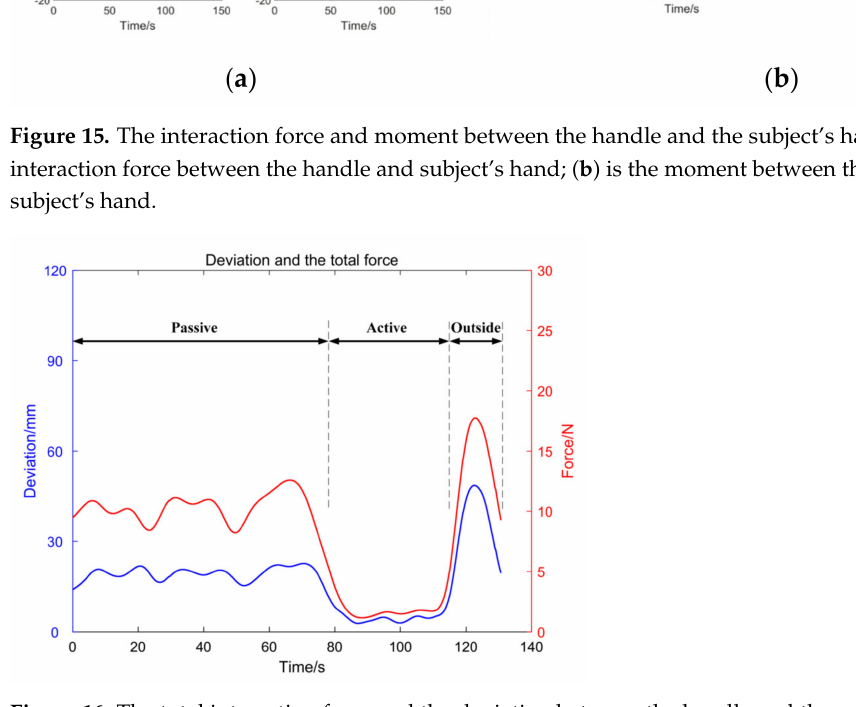
Figure 16. The total interaction force and the deviation between the handle and the subject’s